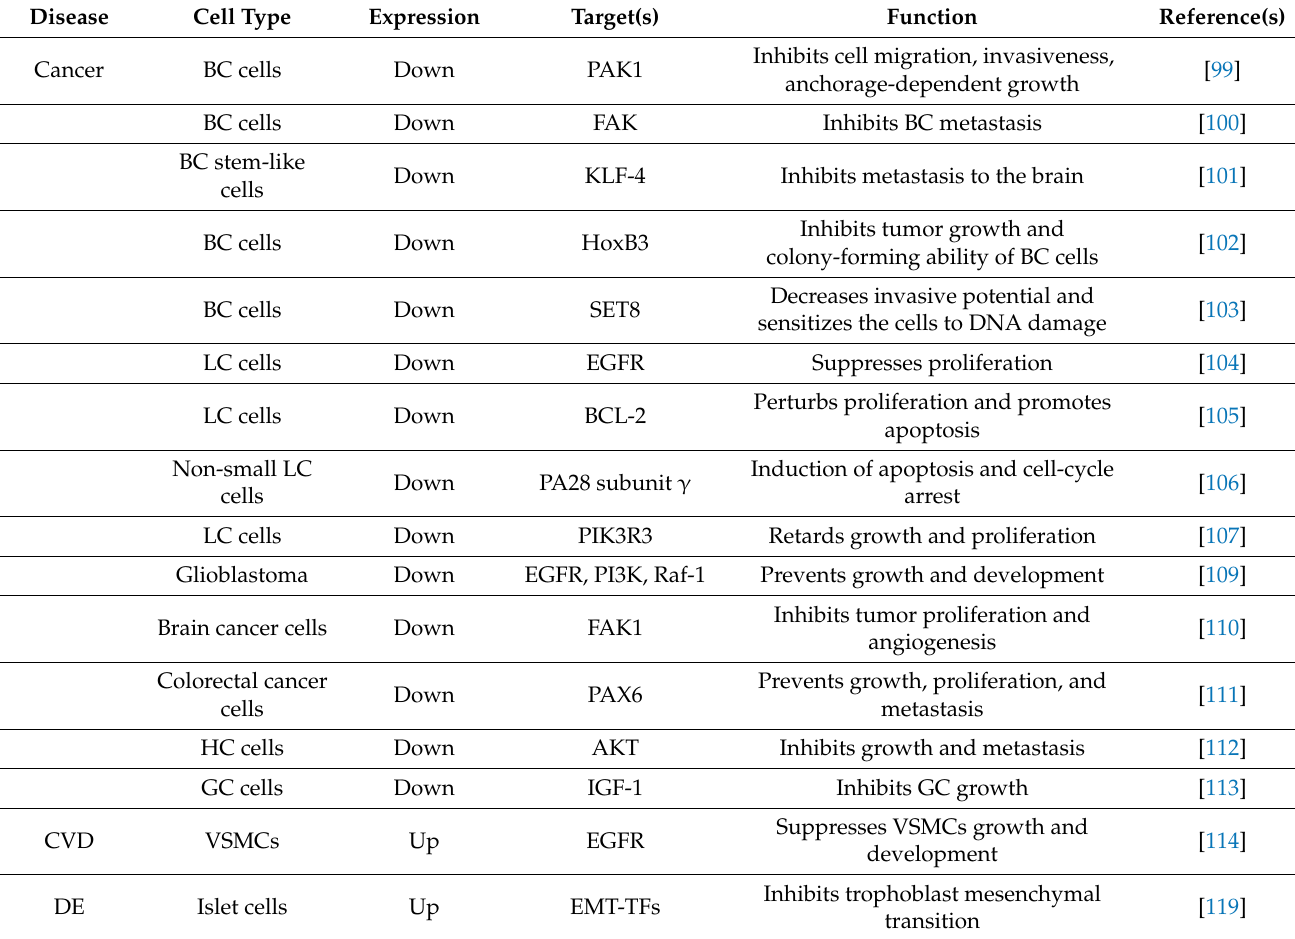
Table 3. The role of miR-7 in various